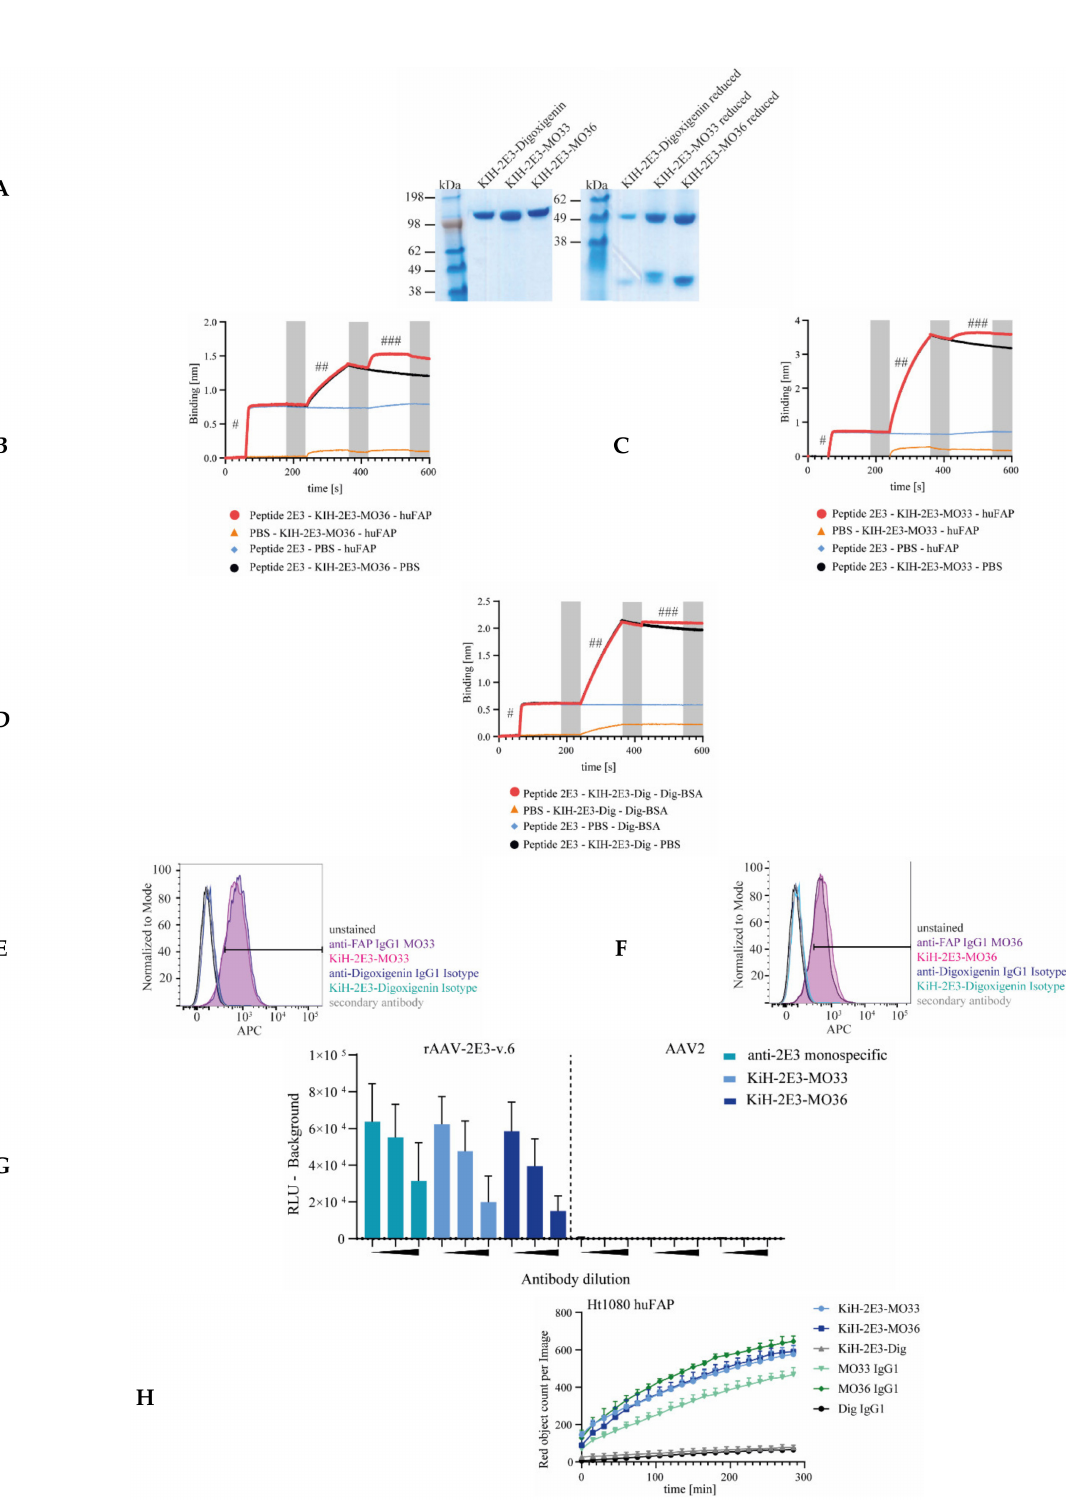
Figure 4. Production and characterization of bispecific antibodies binding both the cell surface receptor FAP and the 2E3 epitope. ( A ) Purified KiH- 2E3-MO33, KiH-2E3-MO36, and KiH-2E3-digoxigenin production analysis under reducing and non-reducing conditions by SDS page and protein staining. ( B – D ) Bridging assay proved the simultaneous binding of 2E3 epitopes and target proteins by KiH-bispecific antibodies. Biotin-labeled 2E3 peptides bound streptavidin tips and resulted in first spectral shift (#), ( B ) KiH-2E3-MO33, ( C ) KiH-2E3-MO36, and ( D ) KiH-2E3-dig interaction with the 2E3 epitope resulted in second spectral shift (##), and interaction with recombinant FAP or BSA-digoxigenin resulted in third spectral shift (###). Wash steps are indicated by grey bars. The novel KiH antibodies were analyzed for FAP binding in comparison to the original ( E ) MO33 and ( F ) MO36 anti-FAP antibodies by flow cytometry staining. ( G ) Comparison of KiH-antibody and anti-2E3 IgG antibody binding of rAAV-2E3.v6 and AAV2 immobilized capsids. Antibody dilutions (1:1000, 1:10,000, and 1:100,000) are indicated by black triangles, and light signals were detected after Sulfo-tag labeled anti-human IgG incubation by MSD ® -ECL. Data show mean ± SD of three independent experiments. ( H ) Human Fabfluor-pH Red Antibody Labeling Dye coupled with bispecific and monospecific antibodies resulted in red fluorescence signals after internalization by HT1080 huFAP cells. Data show mean + SD of two independent